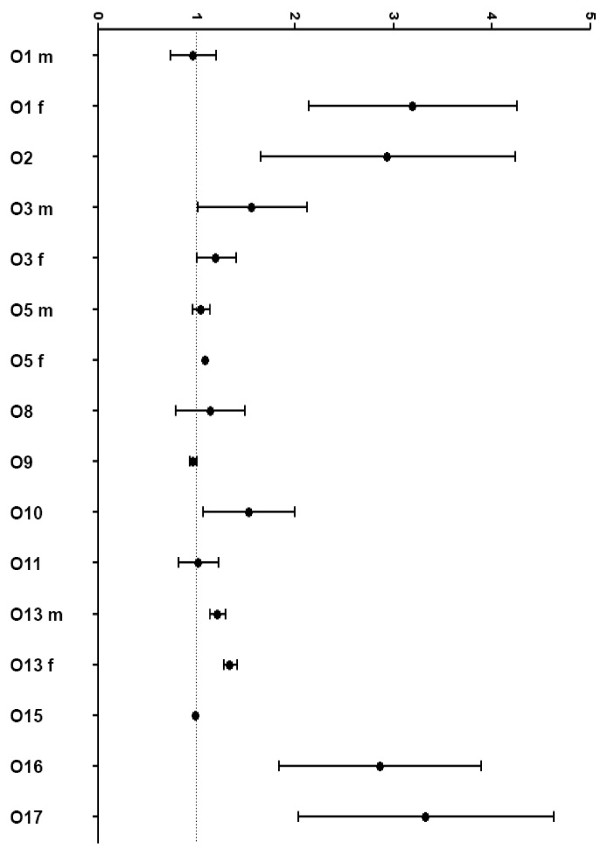
Impact of low SES influencing overweight and obesity. Effect sizes given as OR, HR or RR (central point) flanked by lower and upper 95% CI. Results of O6, O7, and O12 are given as β-coefficients and are not included in Figure 3. In O6 a limited effect of low SES is seen; in O7 and O12 a considerably higher risk for type 2 diabetes incidence in the low SES group can be concluded.